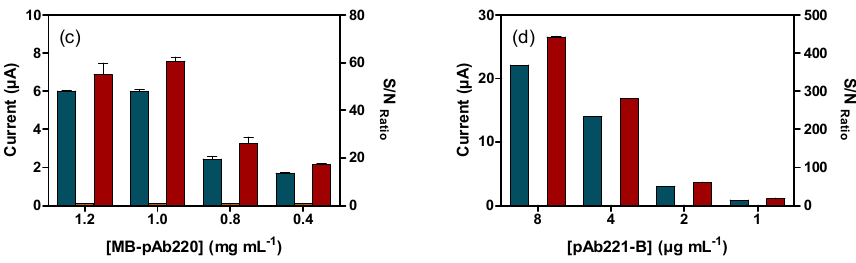
Figure 3. Optimization of the magneto bead-based voltamperometric immunosensor for hcTnI at two different levels (1 µg mL −1 , blue bar, 0 µg mL −1 , yellow bar, S/N ratio, red bar) using cadmium